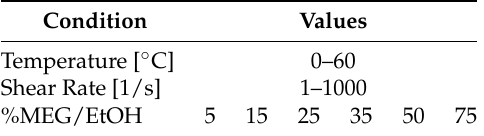
Table 4. Experimental tests for the dynamic viscosity of the MEG/EtOH